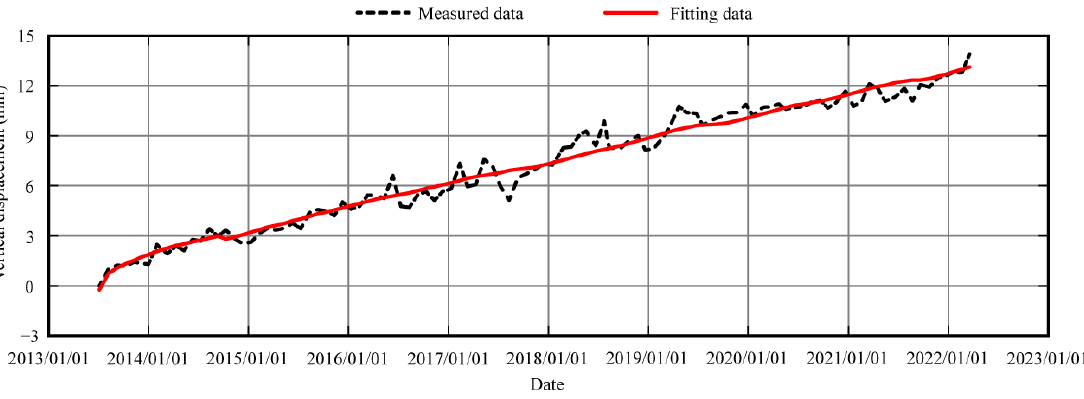
Figure 4. Process lines of settlement for measuring point LD12ZT01 (bidirectional LSTM model).